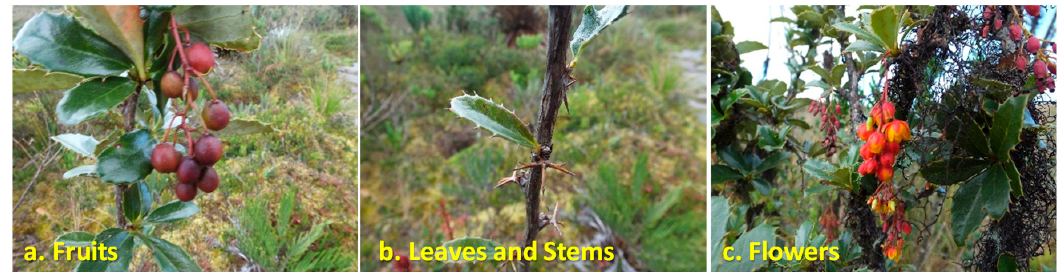
Figure 1. Fruits ( a ), leaves and stems ( b ) and flowers ( c ) from Berberis goudotii Triana & Plach.